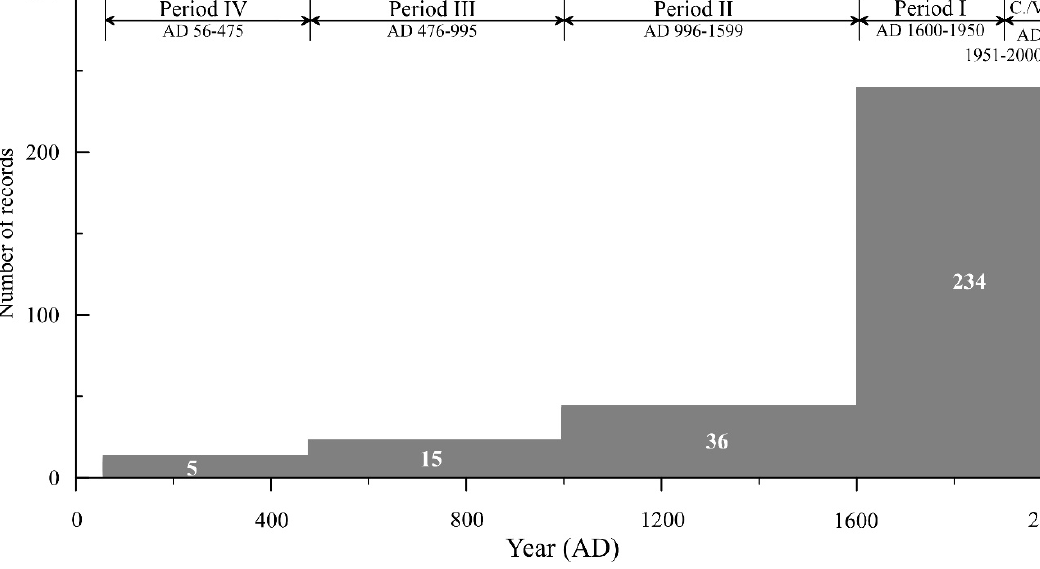
Figure 2. Diagram of the candidate proxy records for each year, and five study periods.